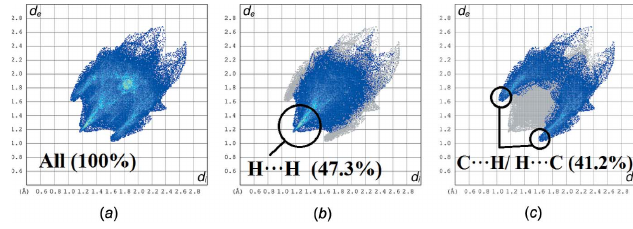
Figure 6 Fingerprint plots of interactions, listing the percentage of contacts ( a ) full two-dimensional fingerprint plots, and ( b ) H (cid:3)(cid:3)(cid:3) H and ( c ) C (cid:3)(cid:3)(cid:3) H/H (cid:3)(cid:3)(cid:3) C contributions to the total Hirshfeld surface. The outline of the full fingerprint plots is shown in